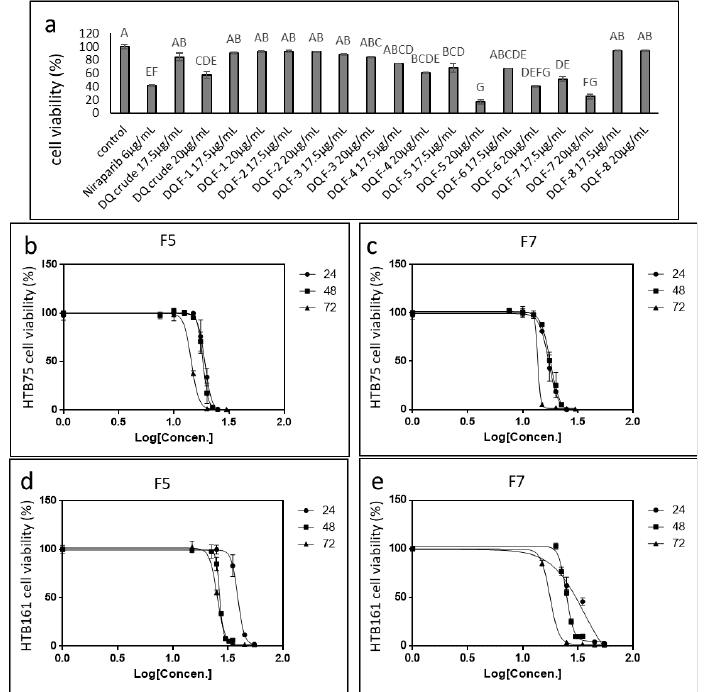
Figure 2. ( a ) Cell viability of HTB75 cells following treatment with DQ extract fractions F1-F8, and the crude extract. Cell viability was determined by XTT assay as a function of live cell number. Control is the vehicle-treated control (1.00% v/v methanol). Error bars indicate ± SE ( n = 3). Levels with different Upper case letters were significantly different from all combinations of pairs according to the Tukey–Kramer honest significant difference test (HSD; p ≤ 0.05). ( b , c ) Cell viability of HTB75 cells following treatment with C. sativa DQ fractions F5 and F7 (respectively) at different concentrations for 24 h, 48 h and 72 h. ( d , e ) Cell viability of HTB161 cells following treatment with C. sativa DQ fractions F5 and F7 (respectively) at different concentrations for 24 h, 48 h and 72 h. IC50 values calculation was done from logistic curve fit using GraphPad Prism version 6.1. Concentration 0 was the vehicle-treated control (1.50% v/v methanol). Error bars indicate ± SE ( n = 3).